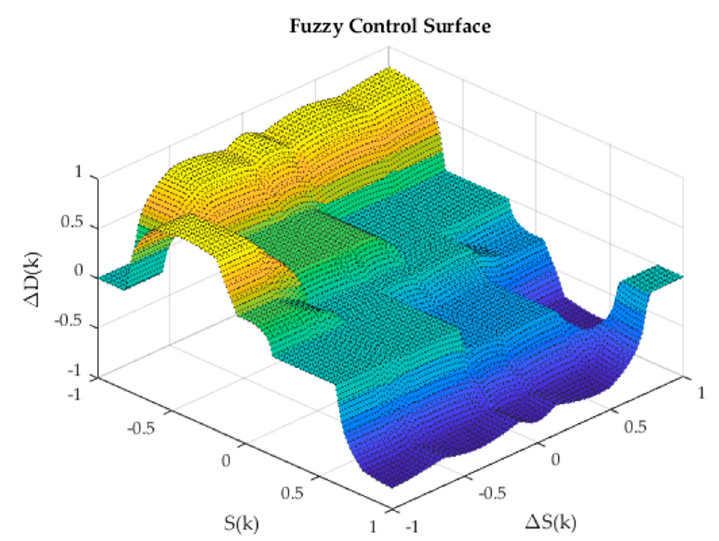
Figure 5. Fuzzy logic control surface.